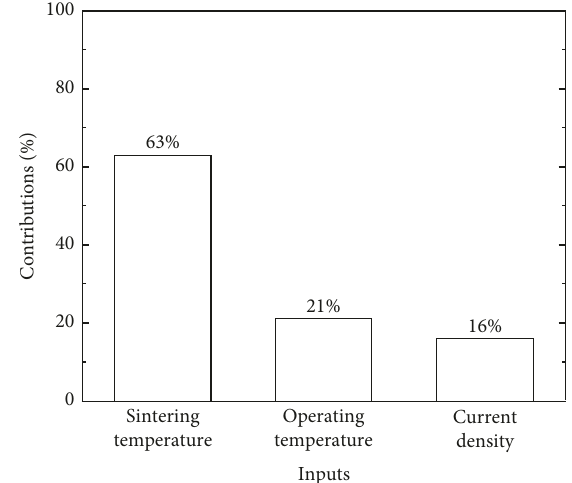
Figure 9: Relative contribution of input variables on cell voltage.